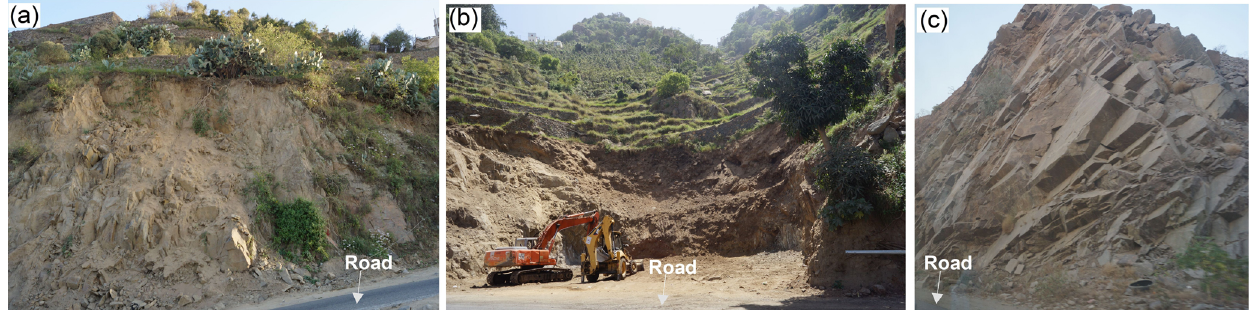
Figure 5. Landslides proximal to, possibly triggered by, road construction and intensified by rainfall. (a) Debris flow caused by failure on steep slopes intersected by roads. (b) Debris flow caused by failure of terraces constructed on steep slopes. (c) Landslide caused by failure on fracture planes dipping towards the road. Table 2. Field observations collected (26 February to 7 March 2016) for the assessment of radar-based distribution of active landslides, the areas exceeding 1 standard deviation (1 SD) on difference images. Locations shown in Fig.